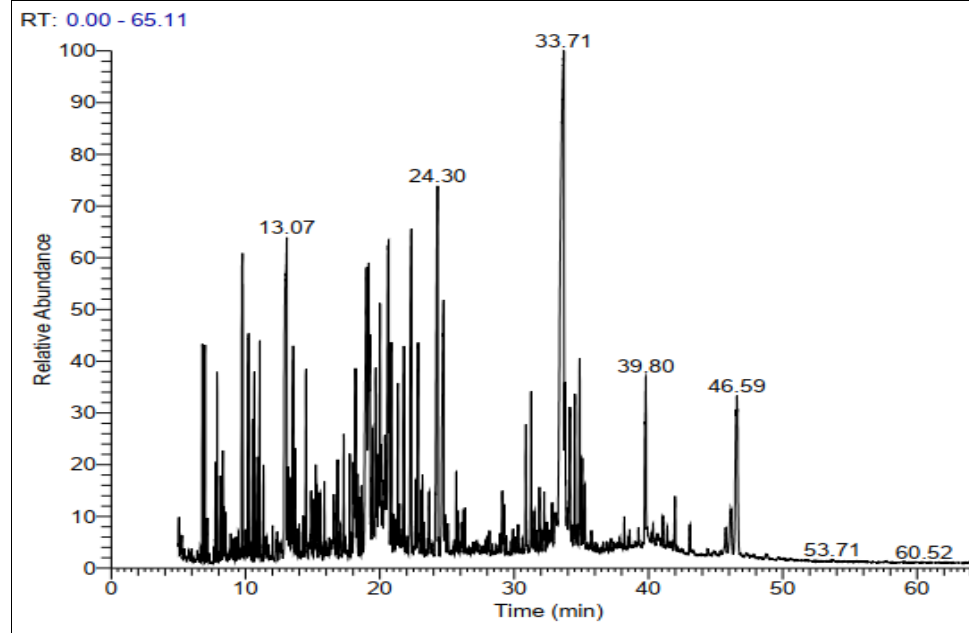
Figure 4. Representative GC-MS chromatogram of derivatized methanolic extract of C. mixtus roots. Table 2. Biomolecule groups of derivatized methanolic extracts from Cladanthus mixtus analyzed by GC-MS.